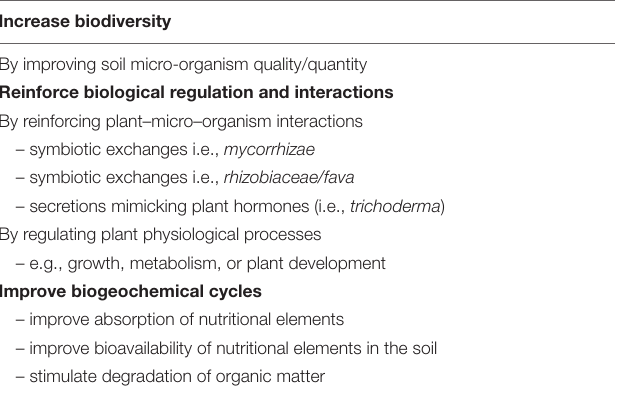
TABLE 1 | Agro-ecological principles and the role played by biostimulants. Increase biodiversity By improving soil micro-organism quality/quantity Reinforce biological regulation and interactions